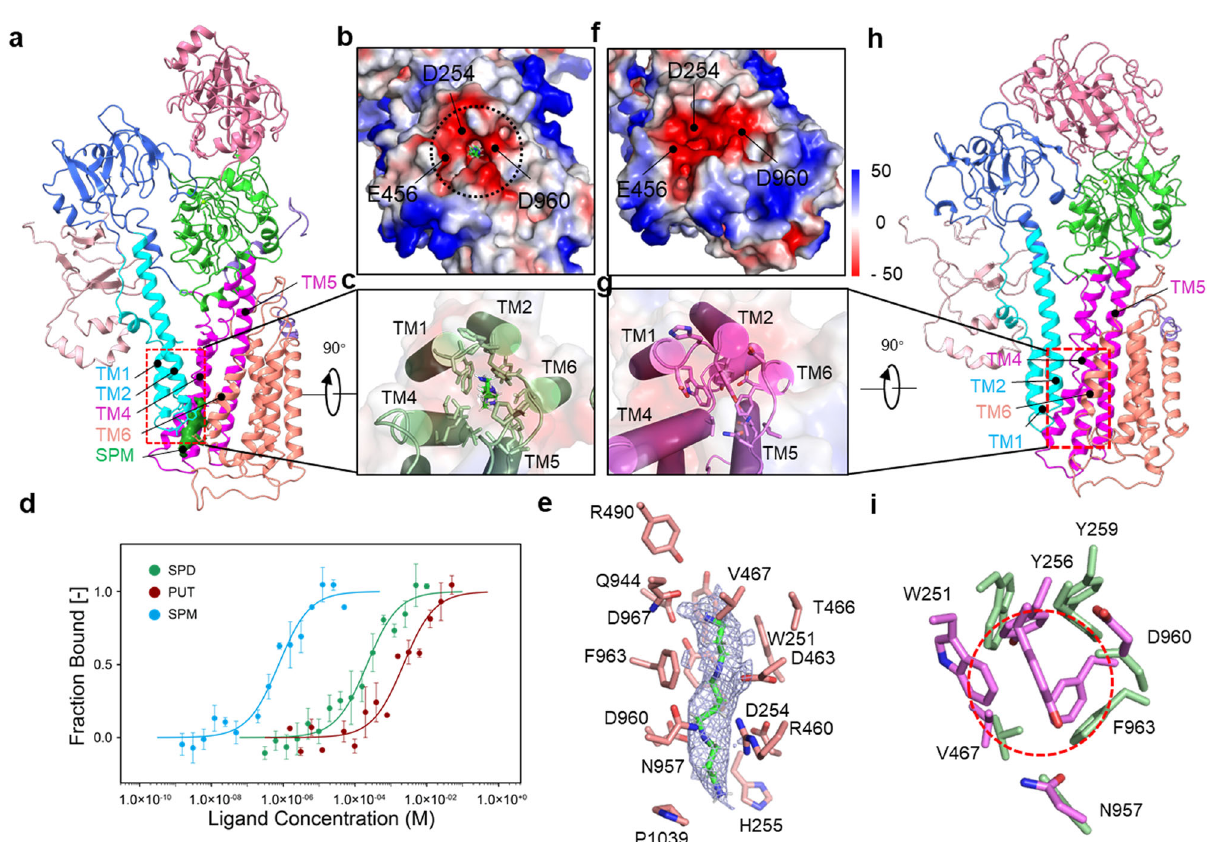
Fig.2|AnalysisoftheentrancesitewithinhATP13A2.a , h The atomic model of hATP13A2 in the E2P state ( a ) and E1-ATP state ( h ), respectively. The EM density of SPM in the E2P state is shown as ChimeraX ’ s “ solid ” (green) representation ( a ). b, f Electrostatic potential surface of Site 1 within E2P ( b ) and E1-ATP states ( f ), respectively, viewed from the luminal side. The substrate-binding cavity is outlinedwithadashedline.ThenegativelychargedaminoacidsD254,E456,and D960 are displayed at the entrance site. c , g The luminal gate is “ opened ” in the E2P structure ( c ) and “ closed ” in the E1-ATP structure ( g ). The SPM molecule is shown as green sticks ( c ). d MST assays of the polyamine-binding af fi nity of